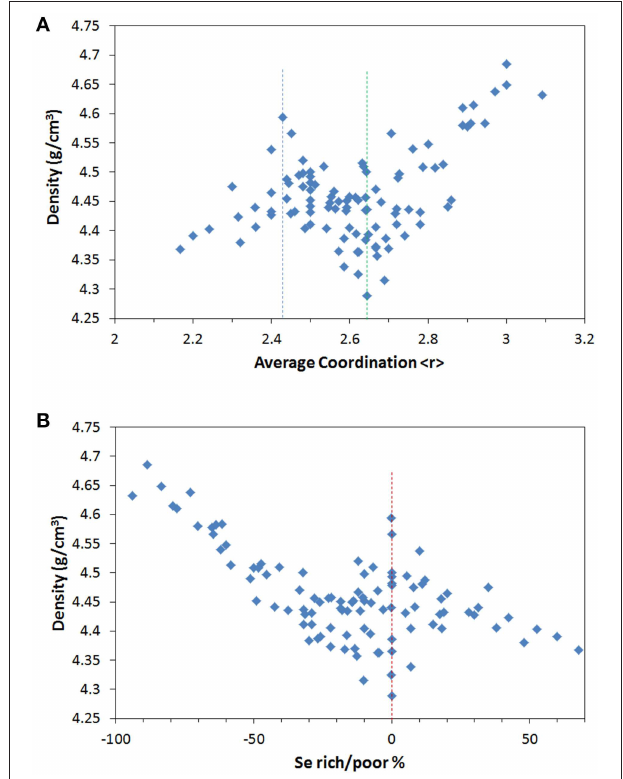
FIGURE 1 | (A) Density of Ge-As-Se glasses as a function of the average coordination number < r > . The dashed line indicate the two extrema associated with topological effects near < r > = 2.4 and structural dimensionality near < r > = 2.67. (B) Density of Ge-As-Se glasses as a function of excess/deficiency of Se in the structure. The dashed line indicates the common extremum for stoichiometric composition. Data taken from Borisova (1981), Aitken (2001), Wang et al. (2009), Wang et al. (2011), Wang et al.